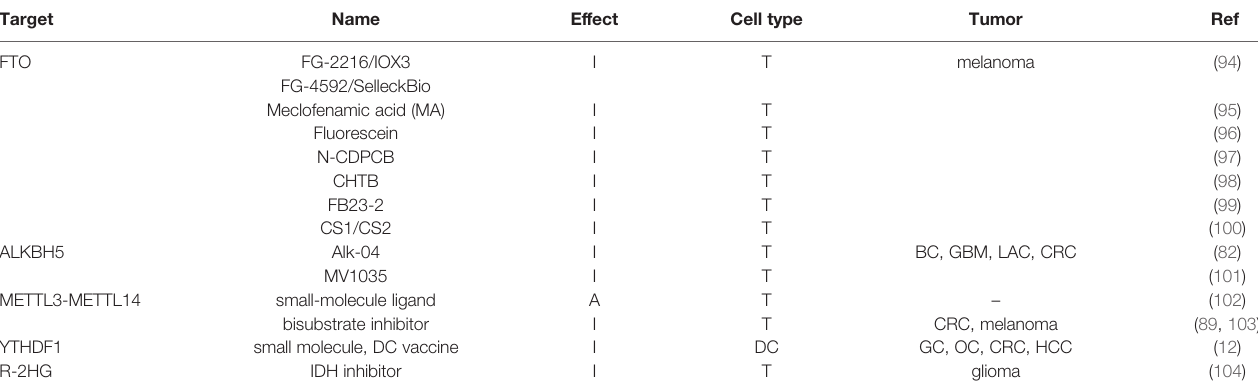
TABLE 1 | Potential strategies for m 6 A-targeting